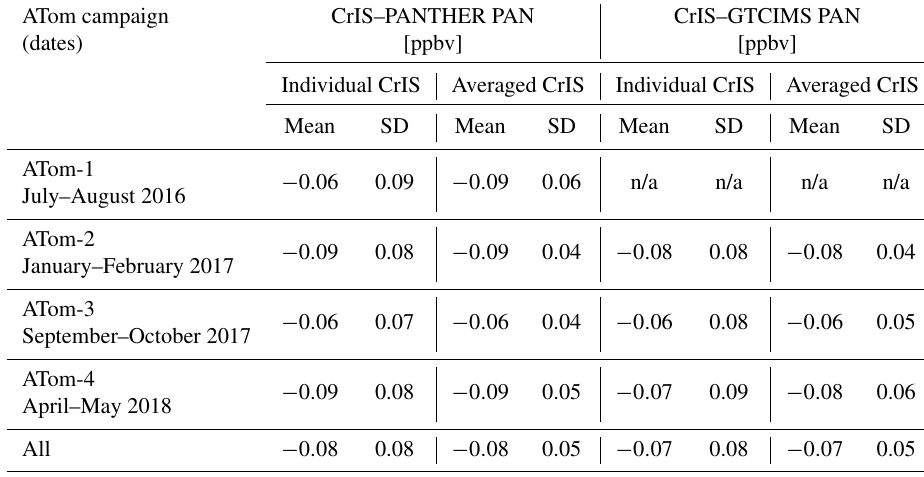
Table 1. Mean and standard deviation of CrIS–aircraft differences by instrument and campaign.